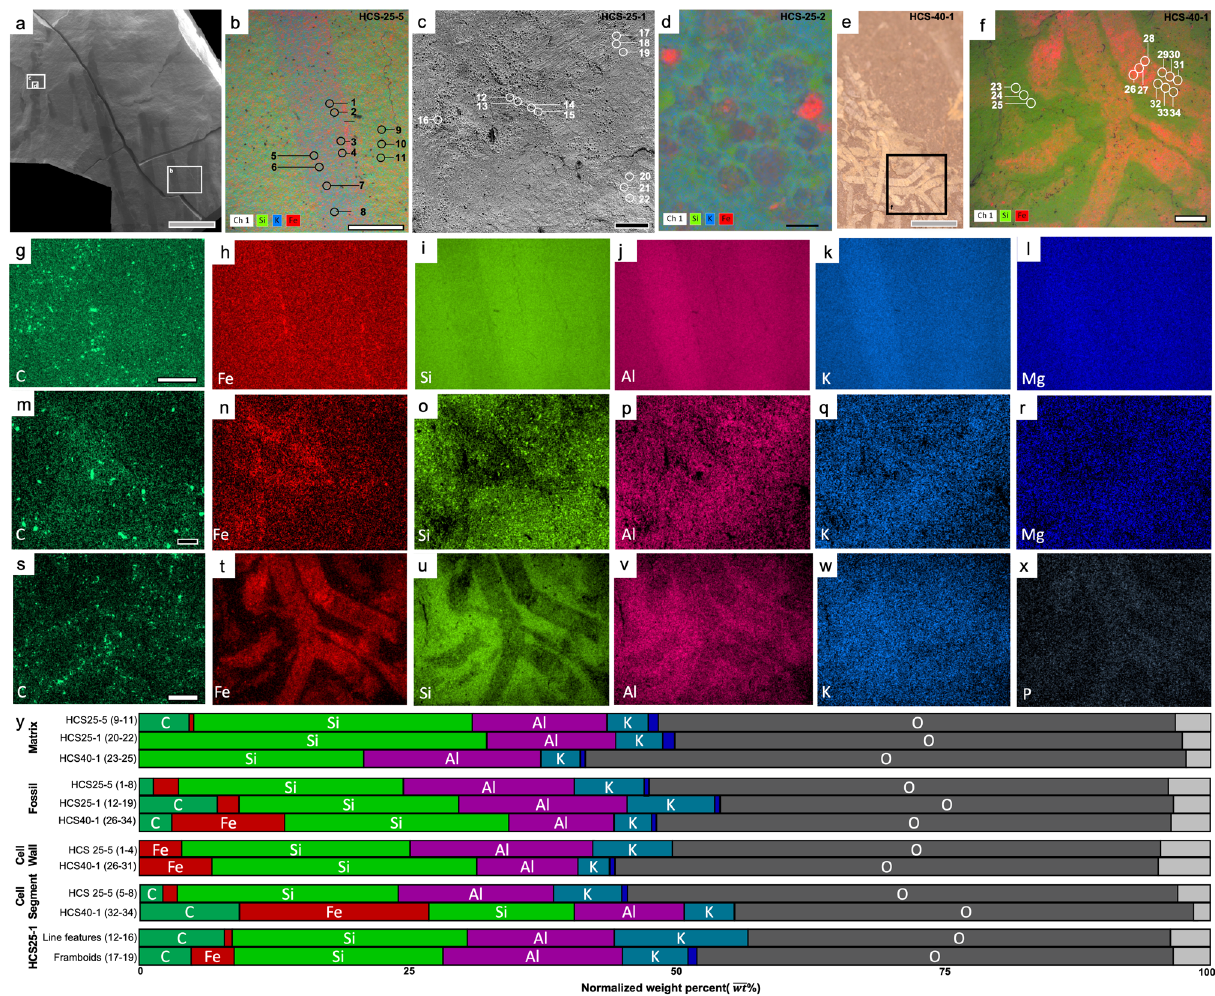
Figure 3. Grade 2: Moderately preserved macroalgae. ( a ) BSE image of moderately preserved specimens (HCS- 25). ( b ) SEM BSE image of ( a ) (larger rectangle) with EDS overlay showing locations of sampled point data and distribution of Si, K and Fe. ( c ) BSE image with of ( a ) showing preservation textures (pits and linear features) and the locations of sampled point data. ( d ) SEM BSE image of ( a ) (smallest rectangle) with EDS overlay showing locations of sampled point data, pyrite textures, and distribution of Si, K and Fe. ( e ) Reflected light image of a moderately-preserved specimen (HCS-40). ( f ) SEM BSE image of ( e ) (rectangle) with EDS overlay showing locations of sampled point data and distribution of Si and Fe. ( g – l ) EDS elemental maps for specimen HCS-25-5. ( m – r ) EDS elemental maps for specimen HCS-25-1. ( s – x ) EDS elemental maps for specimen HCS-40-1. ( y ) Bar plot illustrating the concentration of each element reported as the mean relative intensity in normalized weight percent from EDS point data where Dark Blue = Mg; Light grey = remaining elements. Grey scale = 0.5 cm, white scale with black outline = 0.5 mm, black scale with white outline = 100 microns, black scale = 5